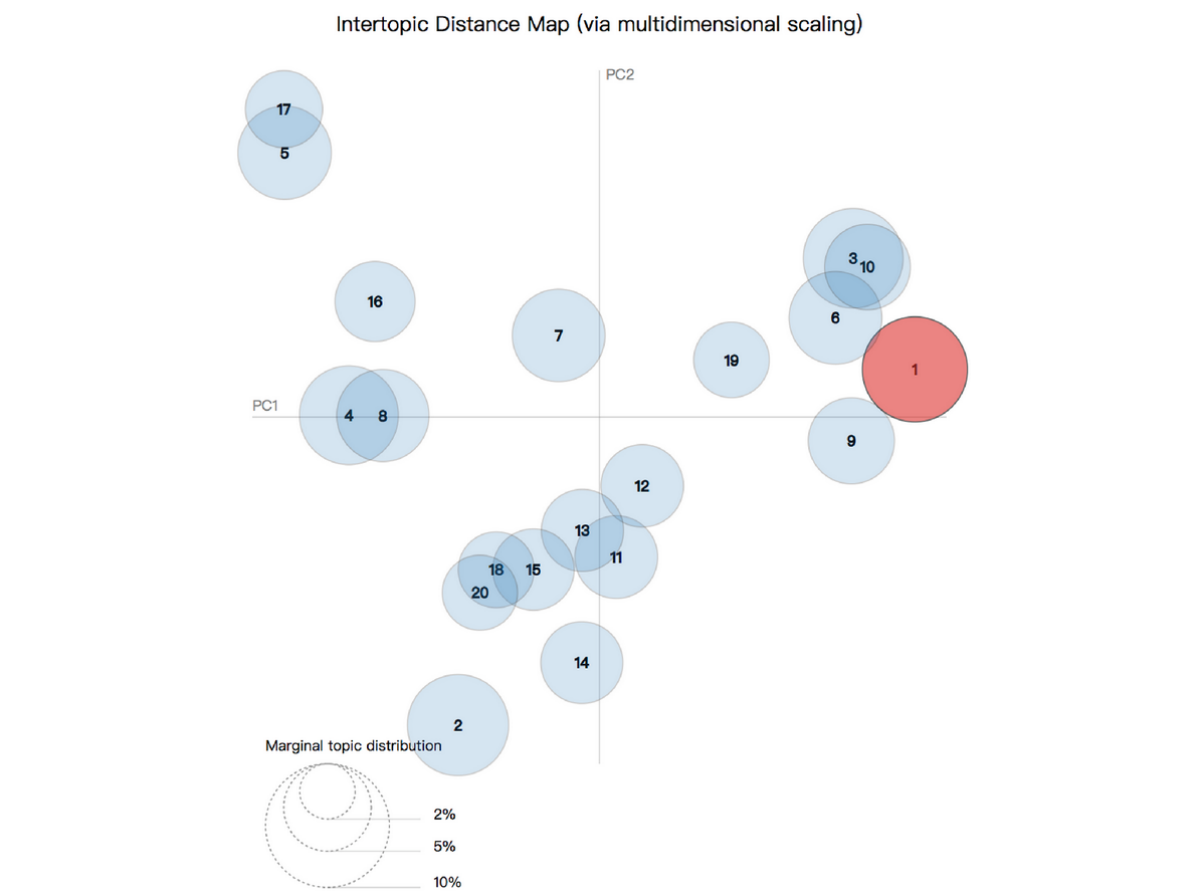
Figure 3. Intertopic distance map. PC: principal